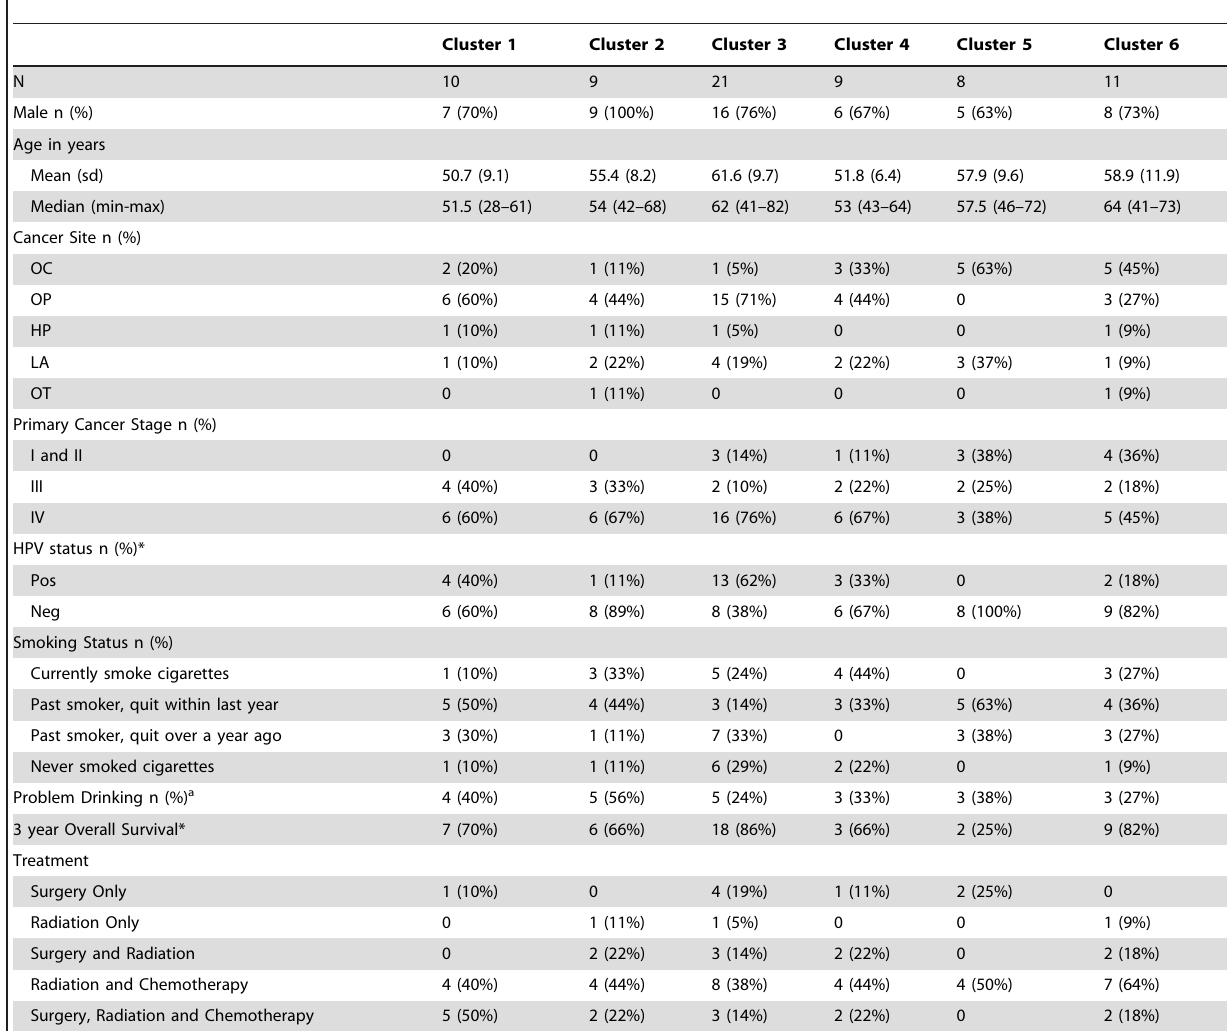
Table 2. Clinical characteristics of the six clusters identified via unsupervised hierarchical cluster analysis of DNA methylation